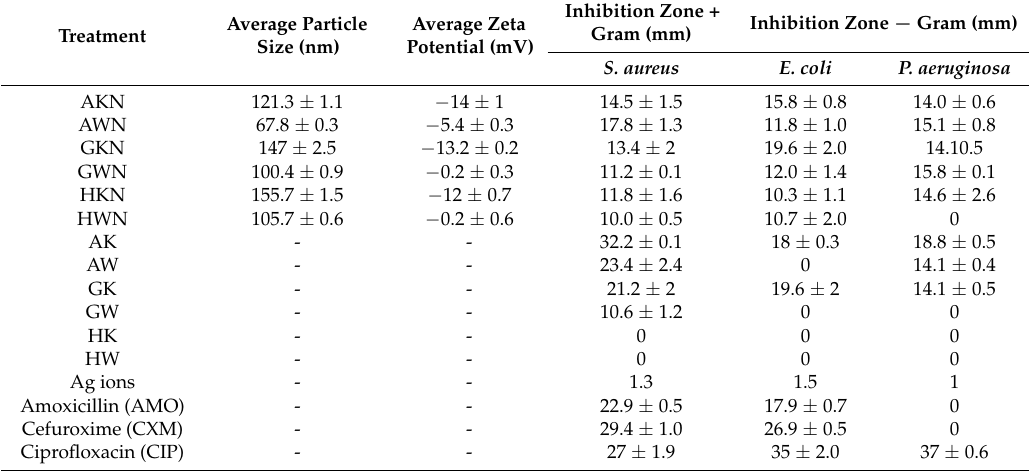
Table 1. Average particle size (nm), Average Zeta potential (mV) of biogenic synthesized silver nanoparticles (AgNPs) and their Zone of inhibition (mm) against Escherichia coli , Staphylococcus aureus , and Pseudomonas aeruginosa